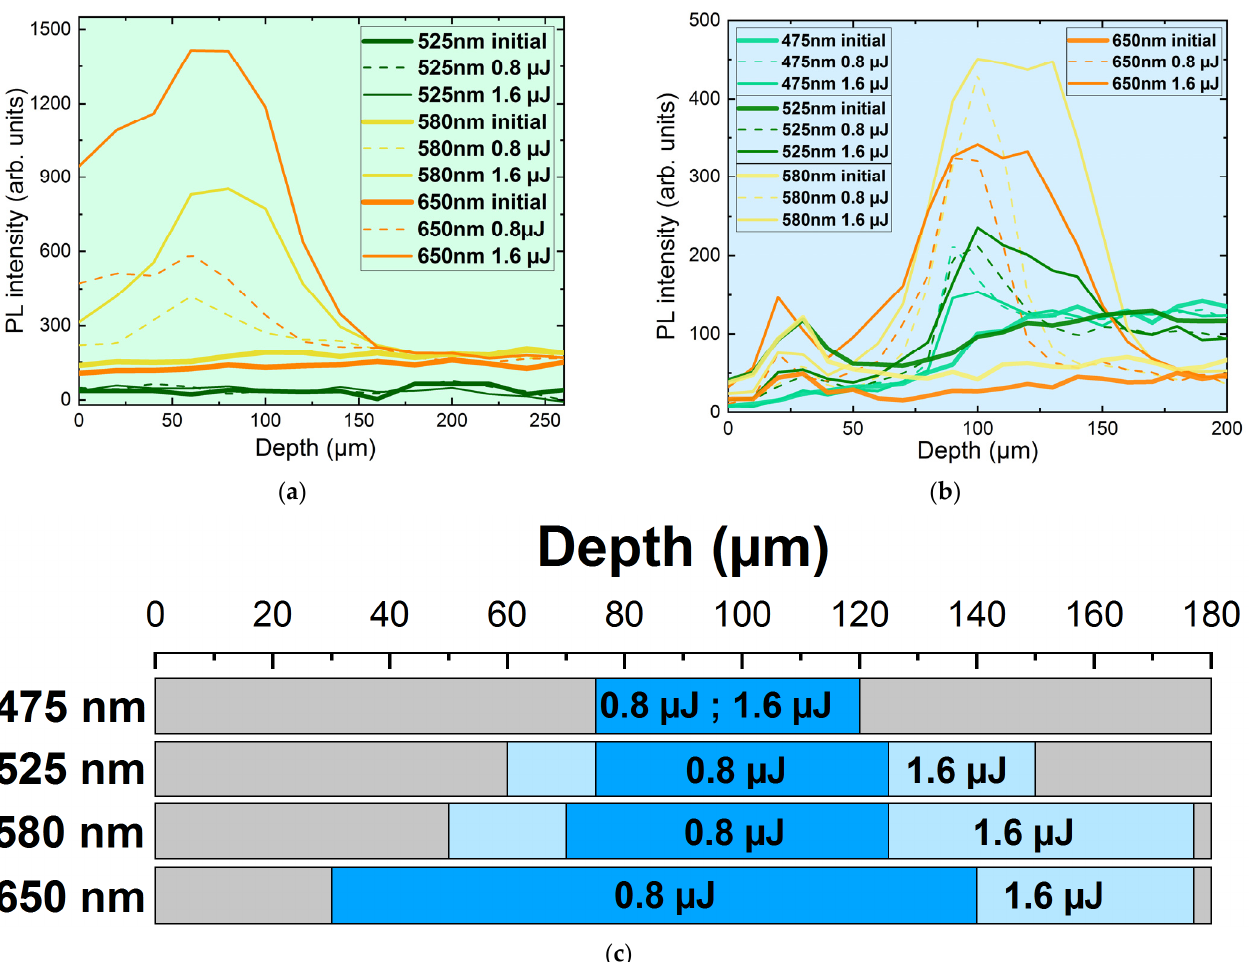
Figure 9. The 532 nm peak intensity at 525, 580, and 650 nm ( a ) and 405 nm peak intensity at 475, 525, 580, and 650 nm ( b ) at different depths versus incident 0.3 ps laser pulse energy; ( c ) the dimensions of micromarks at different energies.